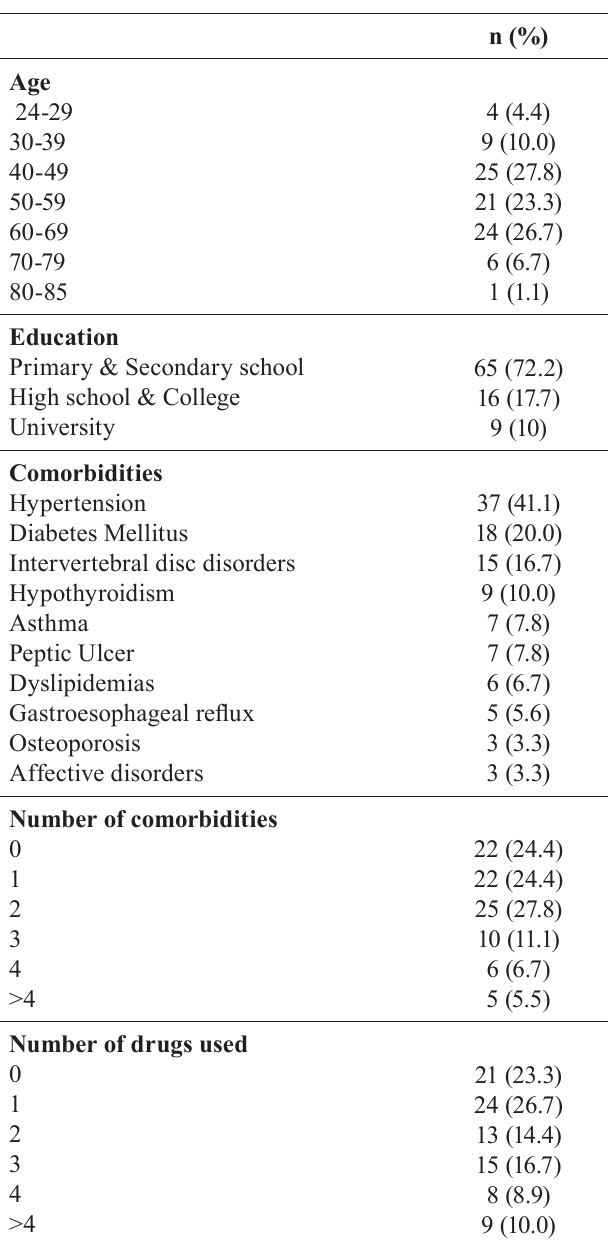
TABLE I - T he demographics of study patients